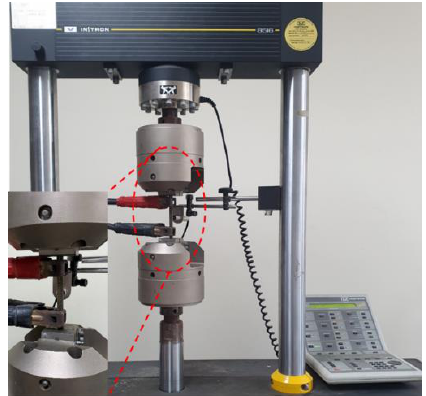
Figure 3. Test set-up for Fe-SMA activation.